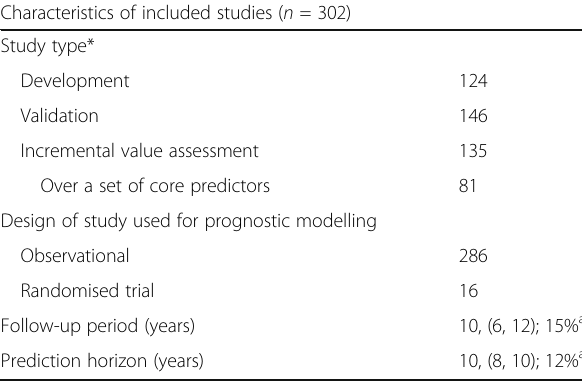
Table 1 General characteristics of the included articles Characteristics of included studies ( n =